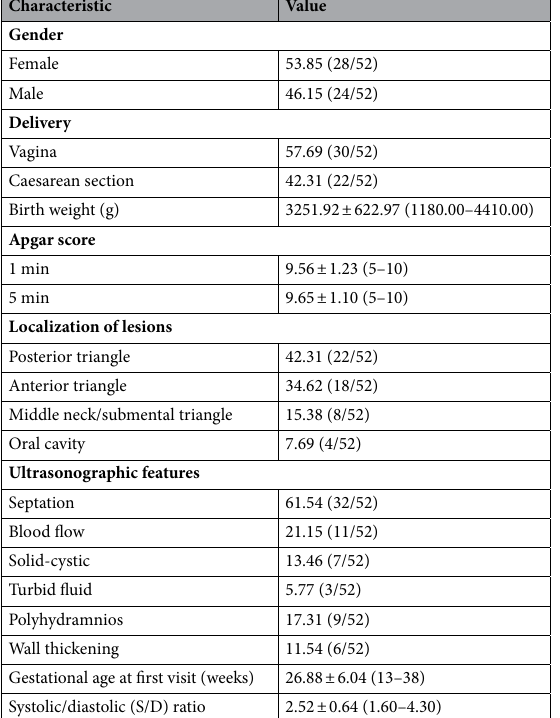
Table 2. Ultrasonographic and clinical features in 52 cases of the surviving fetuses. Data are given as % (n) or mean ± SD